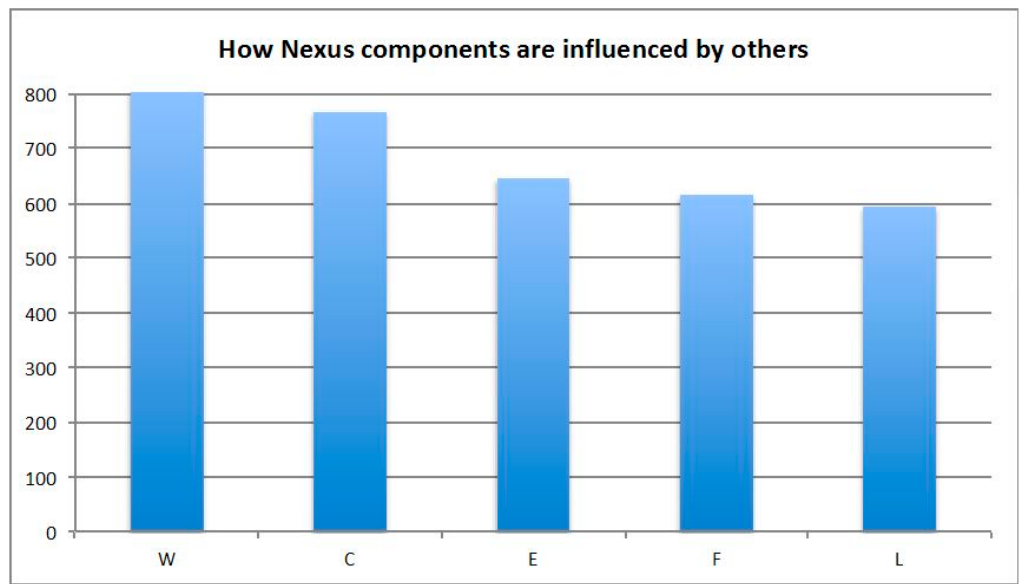
Figure 8. Nexus components and influence scores showing how nexus components are influenced by others.